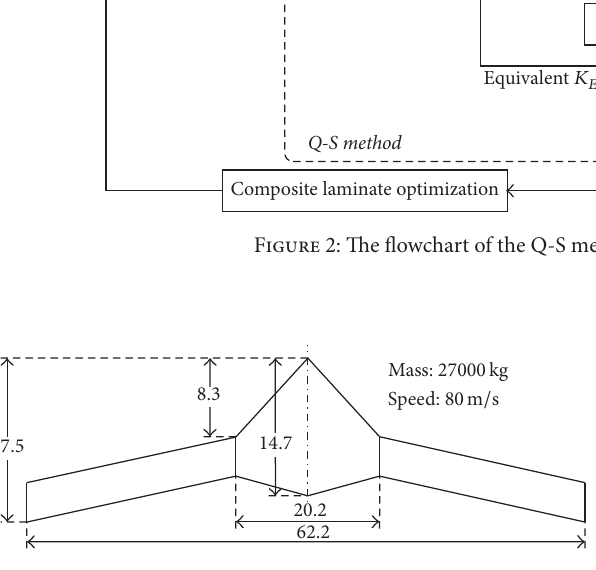
Figure 3: Planform of a flying wing aircraft model (unit: